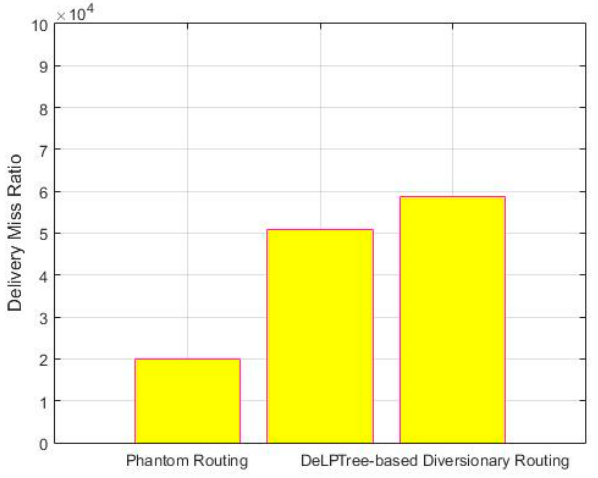
Figure 14. Comparison of Average delivery Miss ratio.